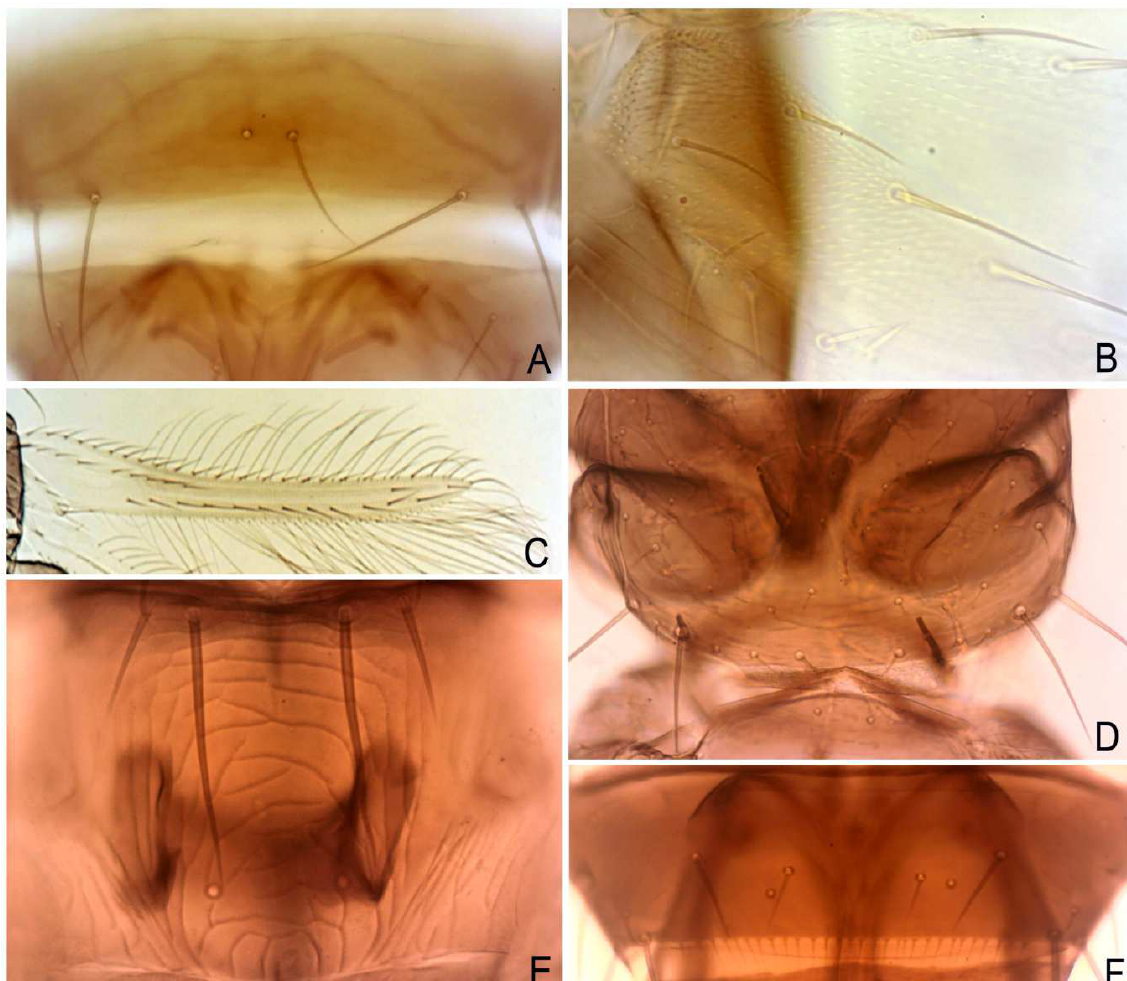
F IGURE 1. Pezothrips dianthi , female: A. abdominal sternite VII; B. clavus; C. forewing; D. pronotum; E. metanotum; F. abdominal tergite